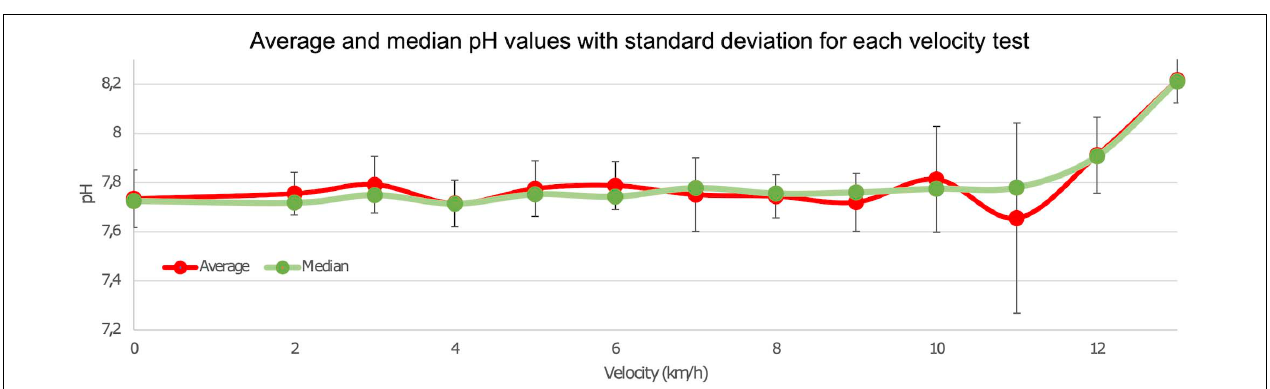
FIGURE 2 | Normalized distribution of seawater pH measurements in relation to platform speed. Velocities from 0 to 13 km/h are plotted. For ease of reading some of them are colored in order to highlight the trend: blue for the 0 km/h curve, green (4 km/h), orange (10 km/h), red (11 km/h) and in dark red the curves corresponding to velocities above 11 km/h. The graph shows that lower velocities exhibit peaks at lower pH values, while increasing the speed, the distribution of pH measurements moves toward higher values.